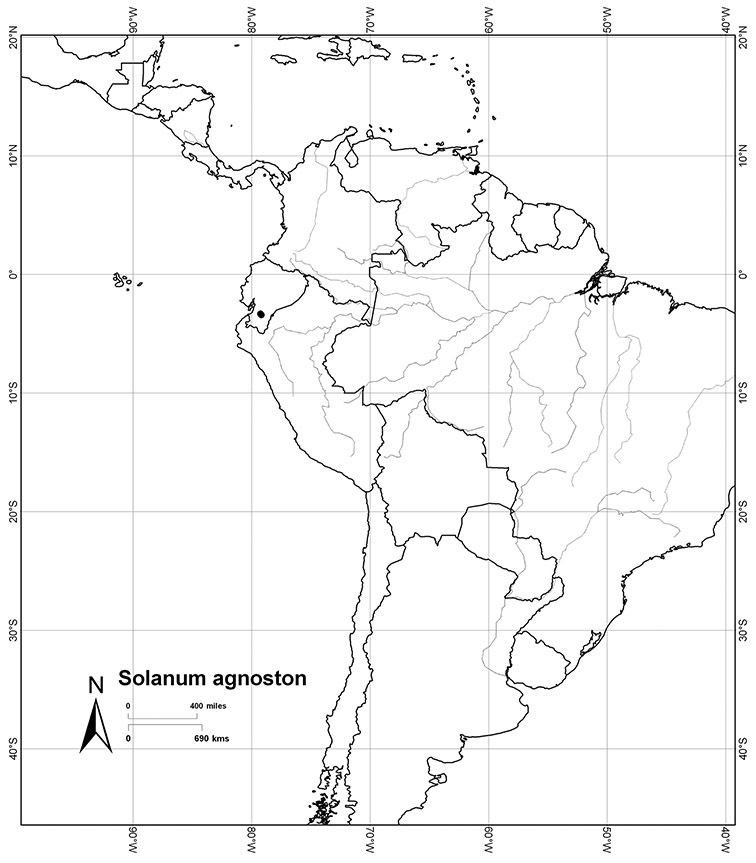
Distribution of Solanum agnoston S.Knapp